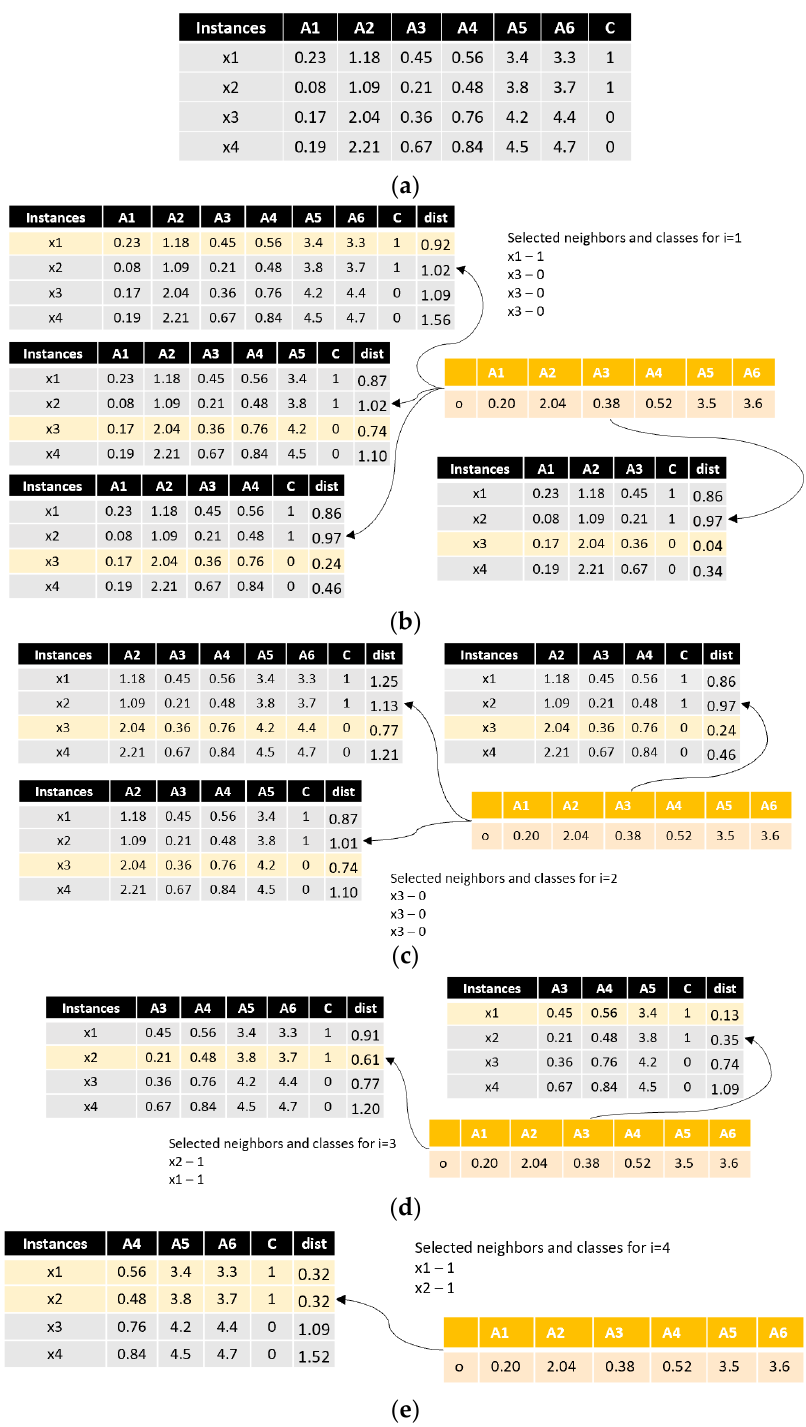
Figure 1. Example of the classification phase of the proposed D1-NN. Note that the original training set is decomposed into several training sets, and the instance to classify (in orange) is presented to each of them. The distance (dist column) is computed, and the nearest instance in each of the resulting training set is highlighted in light yellow. The classes corresponding to the nearest instances are stored. ( a ) Training set; ( b ) Procedure for i = 1; ( c ) Procedure for i = 2; ( d ) Procedure for i = 3; ( e ) Procedure for i = 4. Finally, the LAST STEP: Decision.